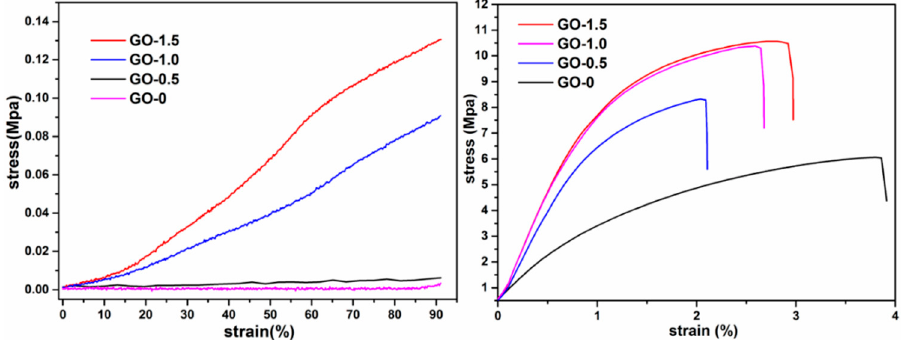
Figure 4. The compressive stress-strain curves ( left ) and tensile stress-strain curves ( right ) of CSAs/GO aerogels.